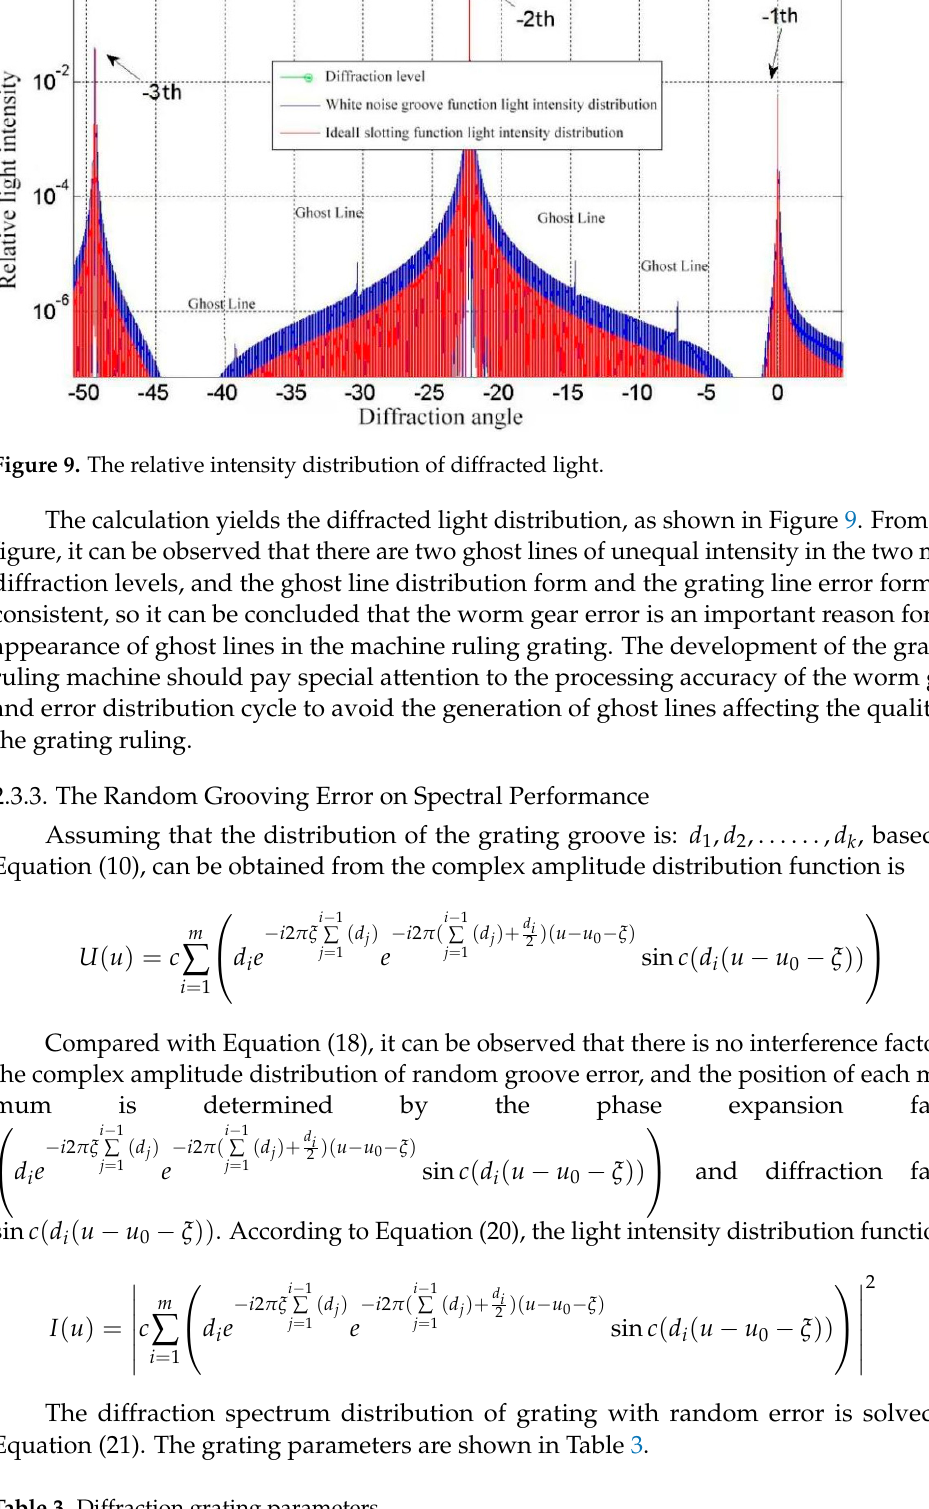
Table 3. Diffraction grating